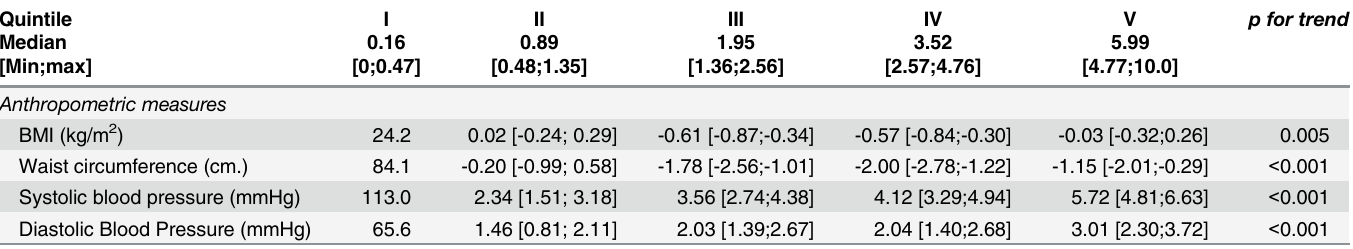
Table 2. Quantile regression models for the main outcomes by length of incarceration quintiles.